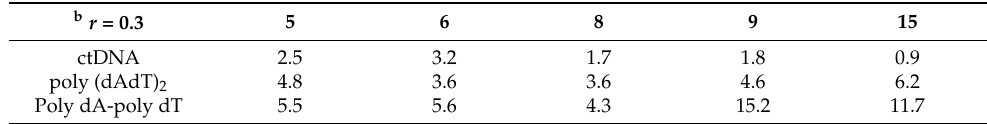
Table 4. The a ∆ T m values ( ◦ C) of studied ds- polynucleotides upon addition of ratio b r = 0.3 of 5, 6, 8, 9, and 15 at pH 7.0 (sodium cacodylate buffer, I = 0.05 mol dm − 3 ). b r =